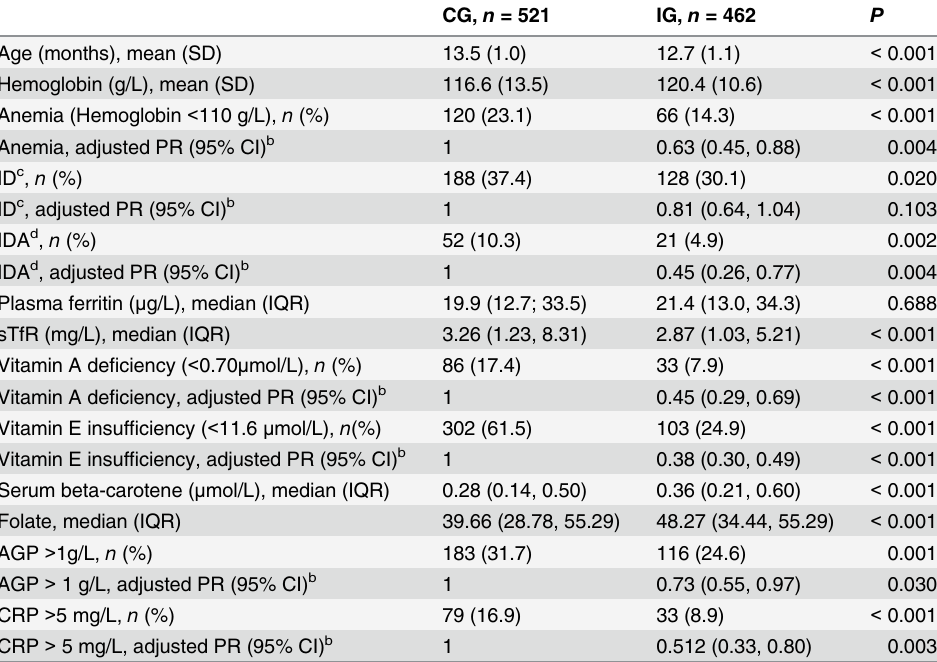
a Totals differ from the total number of study children due to missing values. AGP, α -1-acid glycoprotein; CG, control group; CRP, C-reactive protein; ENFAC, Estudo Nacional de Forti fi caç ã o caseira da Alimentaç ã o Complementar ; ID, iron de fi ciency; IDA, iron de fi ciency anemia; IG, intervention group; PR, prevalence ratio; sTfR, soluble transferrin receptor. b P values were determined by testing the null hypothesis that each variable is equal between groups by using mixed-effects Poisson regression models, adjusted for health center, city, maternal education